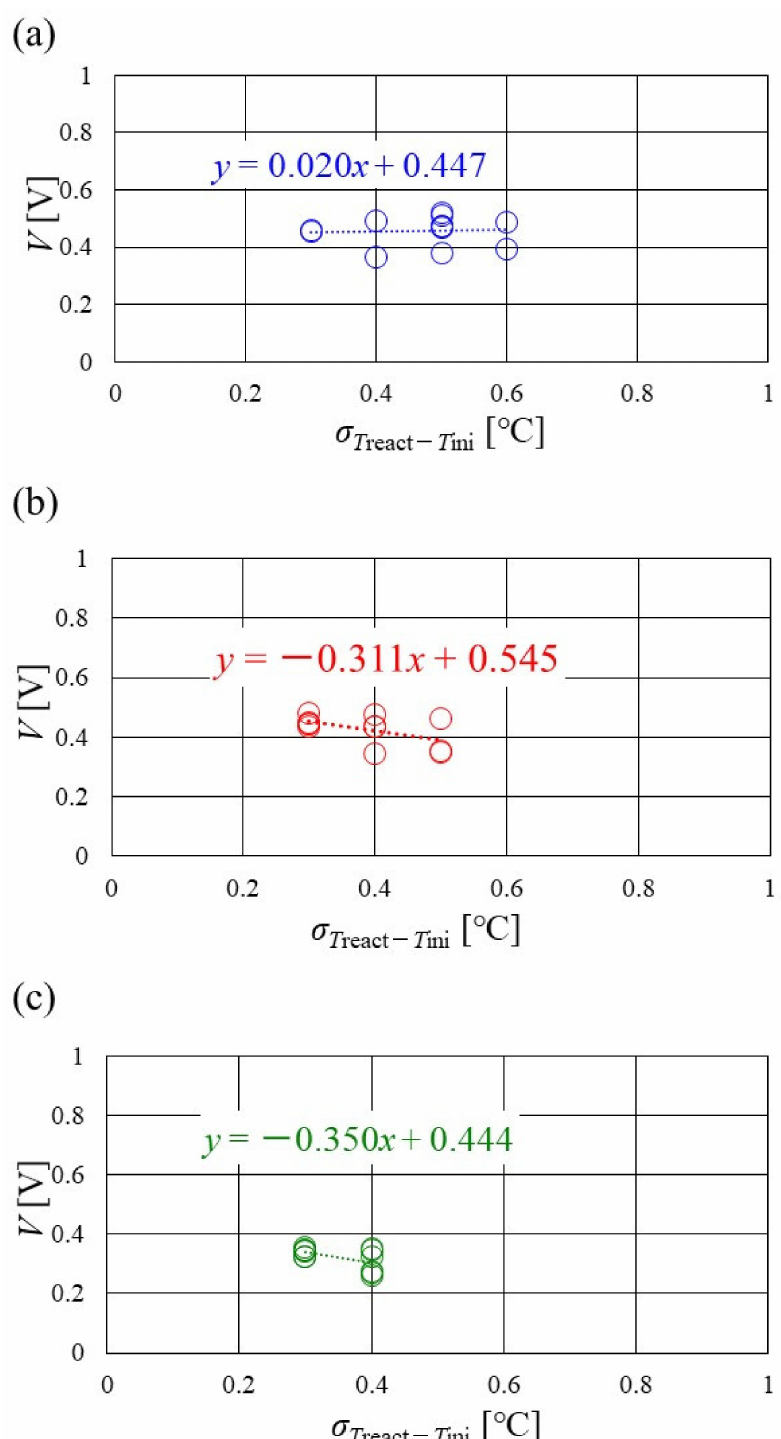
Figure 17. Relation between standard deviation of distribution of temperature difference, between temperature at reaction surface and initial operation temperature and total voltage, in the case of a separator thickness of 1.5 mm: ( a ) the initial operation temperature = 80 ◦ C, ( b ) the initial operation temperature = 90 ◦ C, ( c ) the initial operation temperature = 100 ◦